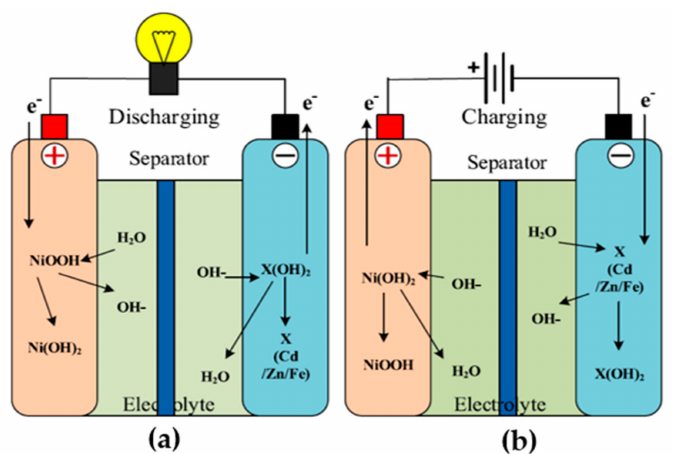
Figure 5. Chemistry of nickel-based battery, ( a ) during discharging, ( b ) during charging